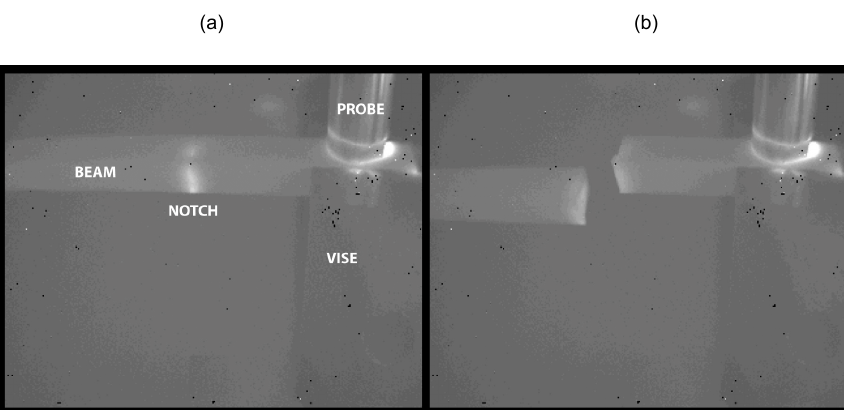
Figure 18. Photograph of ( a ) the thermal signature from the cracked beam couponand ( b ) the eventual fracture of the cracked beam coupon (reproduced from [43] with